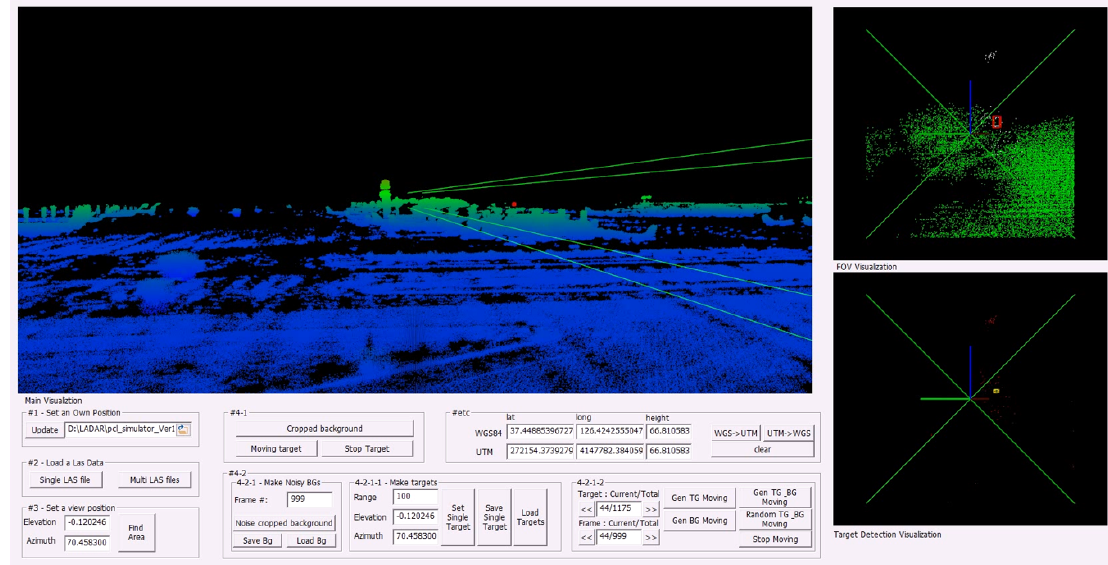
Figure 10. GUI software environment for small target detection.